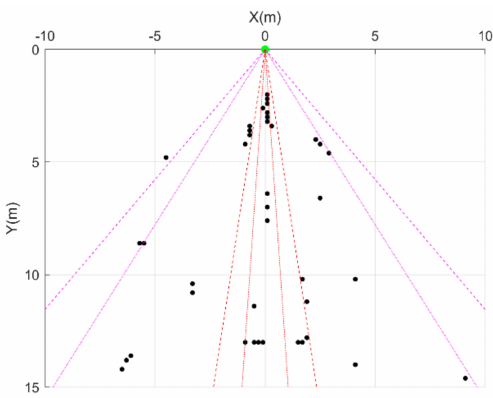
Figure 7. Total points observed from R1 in a typical ‘Empty Field’ measurement scenario. To conclude, using the aforementioned formulation for MWF1, Table 4 depicts the MWF1 scores and accuracies achieved by the C1, C2 and their